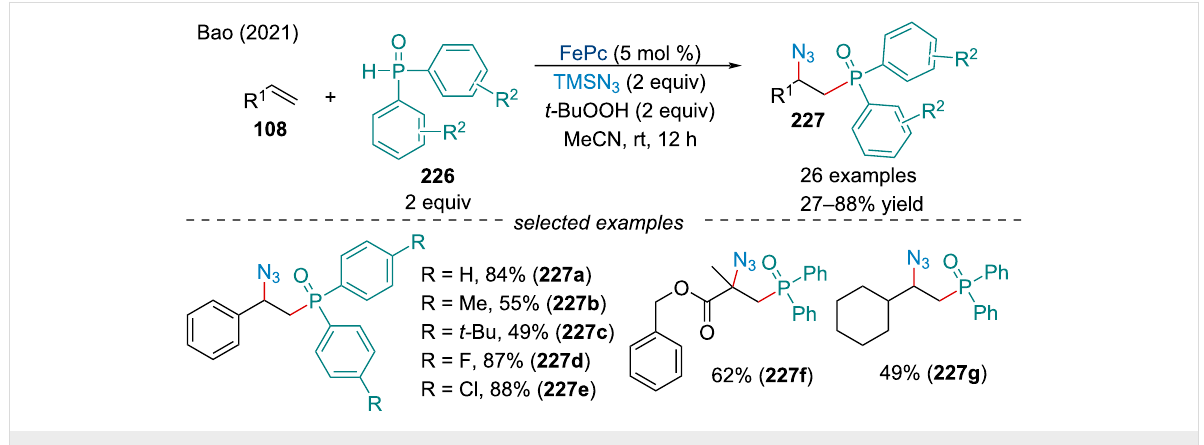
Scheme 52: Iron-catalyzed phosphinoylazidation of alkenes 108 .